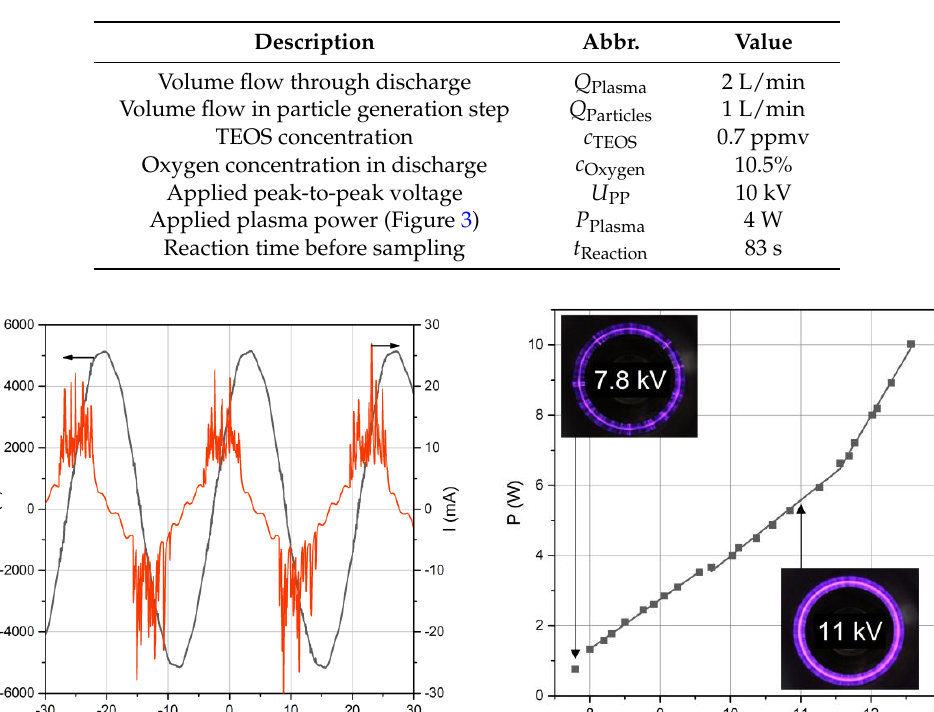
Table 1. Summary of the standard experimental conditions.